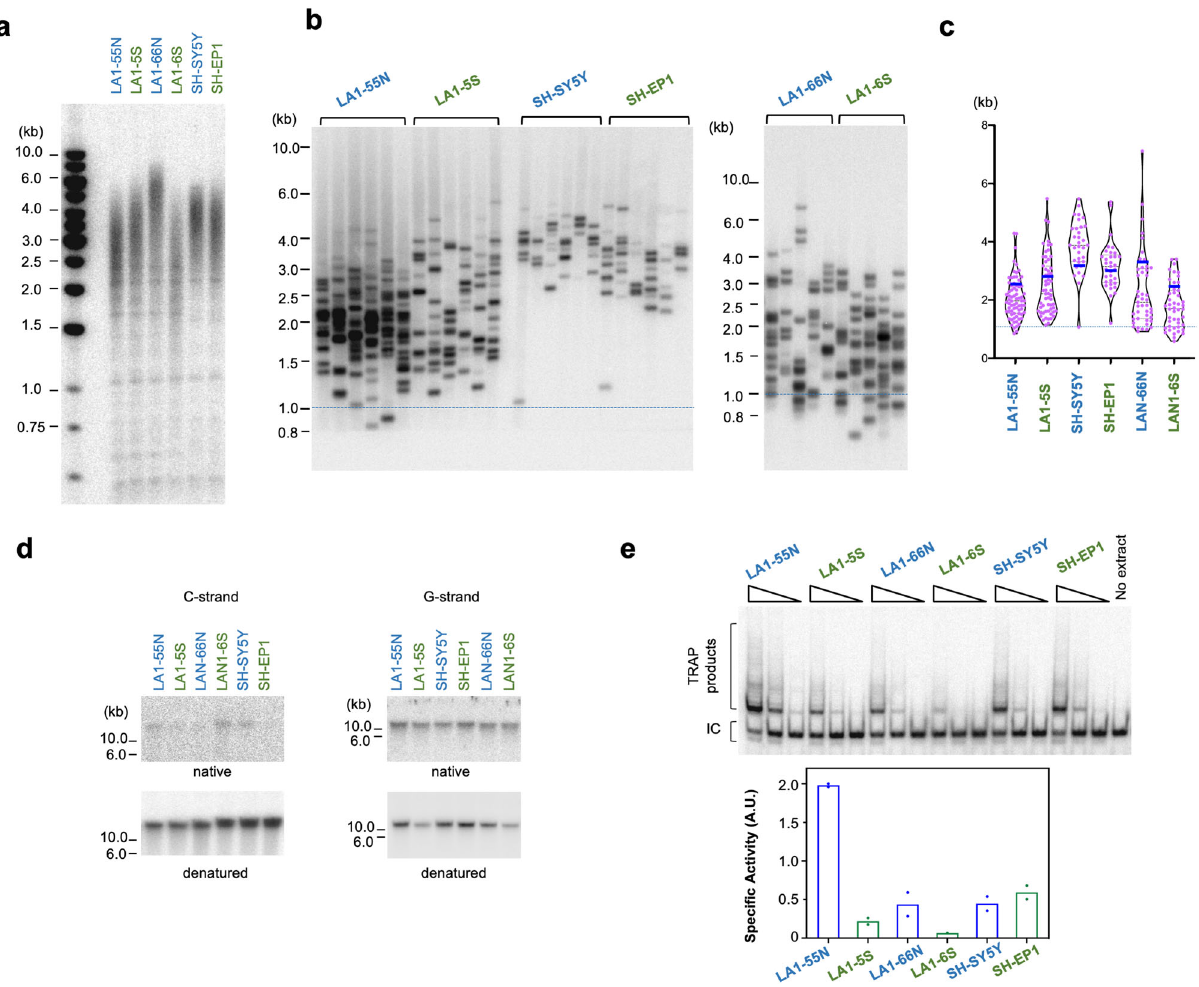
Fig. 2 Characterization of telomere lengths, telomere ssDNA, and telomerase activity in matched ADRN and MES cell lines. a The telomeres of the indicated cell lines were subjected to TRF Southern analysis. b The telomeres of the indicated cell lines were subjected to STELA analysis. Extra-short telomeres (<1 Kb) are demarcated by horizontal red lines across the panels. c The STELA fragments from each cell line in b ( n = 6 PCR reactions) were analyzed using TeSLA software and the pooled results presented as violin plots with medians and quartiles. d The amount of ssDNA in the telomere G- and C-strand in the indicated cell lines were analyzed by native in-gel hybridization. e Telomerase activities in the indicated cell lines were analyzed by TRAP and plotted (means, n = 2 independent